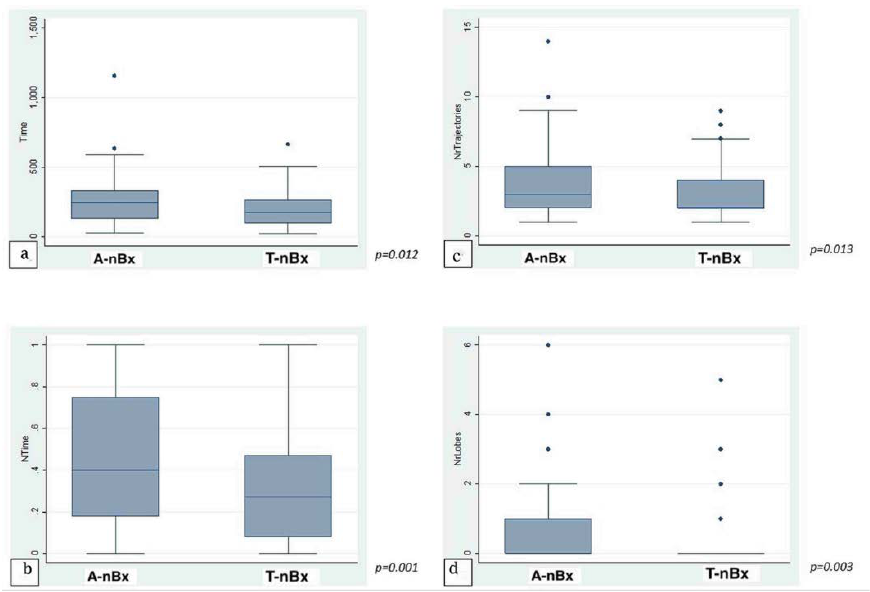
Figure 2. Trajectory enhanced nBx vs Anatomy-based nBx group—box-plot analysis. ( a ) Absolute time comparison ( Y axis—time in seconds); ( b ) Normalized time comparison; ( c ) Trajectory changes; ( d ) Lobe changes. ( NrTrajectories—Number of trajectory changes; NrLobes—Number of Lobe changes).